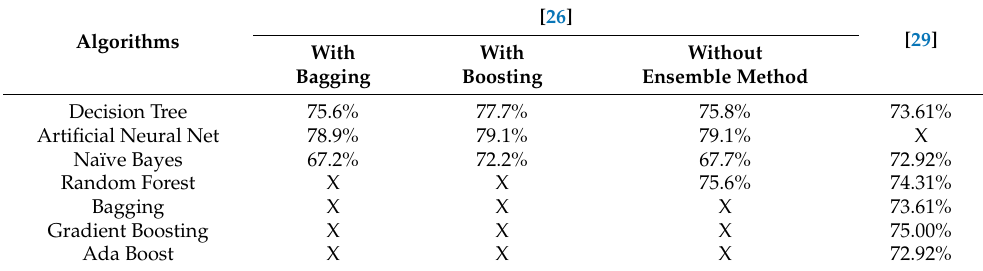
Table 1. Algorithms applied in previous work using Kalboard 360